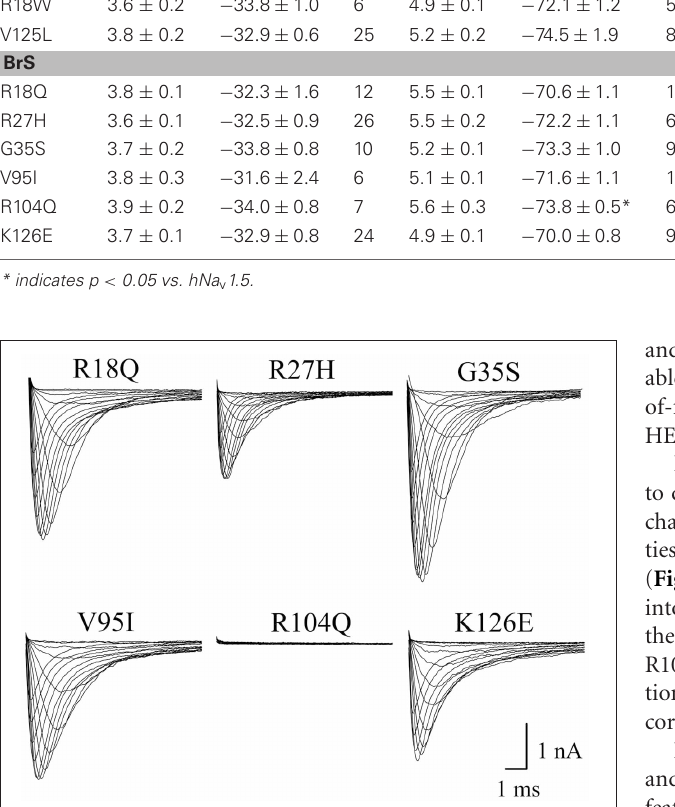
FIGURE 4 | Whole-cell Na + currents upon expression in HEK293 of hNa v 1.5 mutant channels associated with BrS. Currents were elicited from − 80mV to various test pulses in 5 or 10mV increments at a pulsing frequency of 1.0Hz (holding potential − 120mV). For average peak current densities see Table 1 . Expression of R104Q did not result in functional channels in the mammalian expression system.